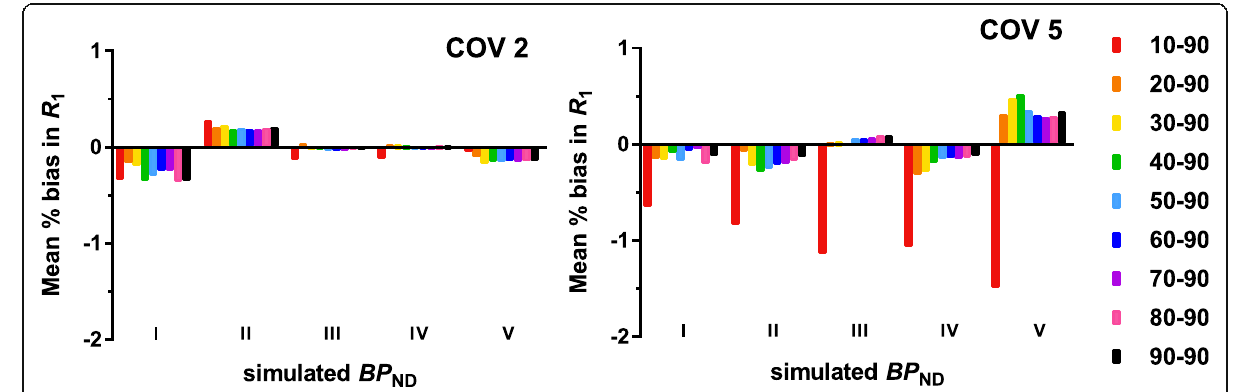
Fig. 6 [ 18 F]florbetaben: percentage bias in SRTM-derived R 1 across the range of BP sim